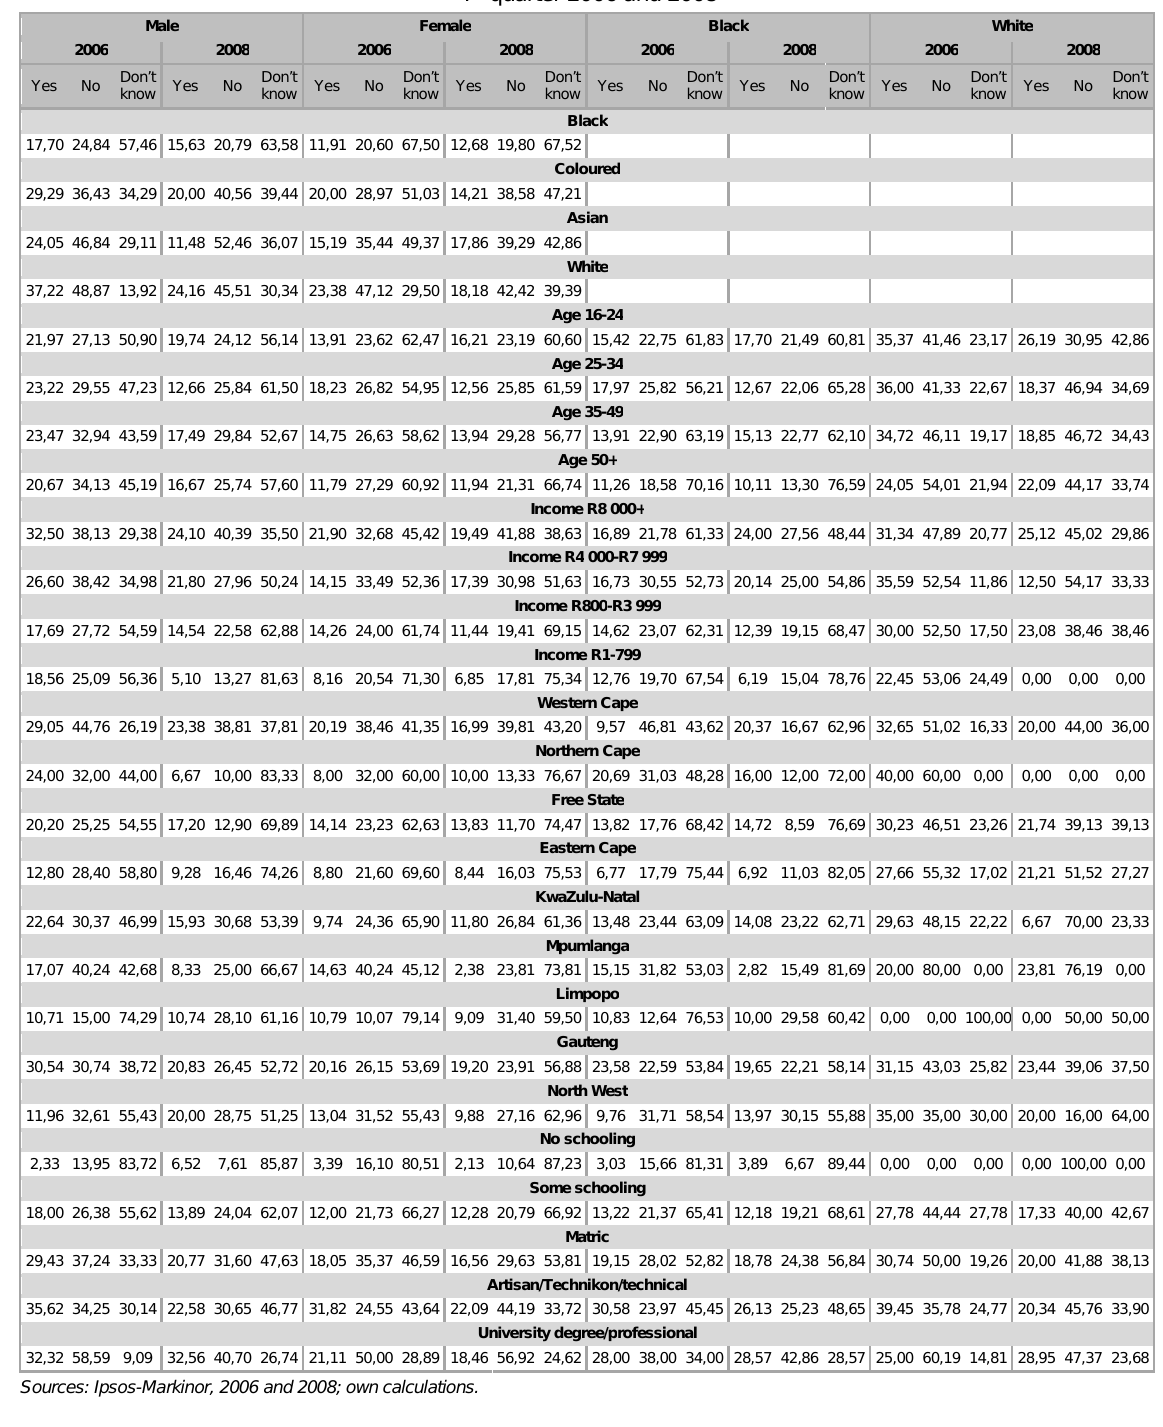
Responses about inflation credibility according to gender and black and white population groups, 4 th quarter 2006 and 2008